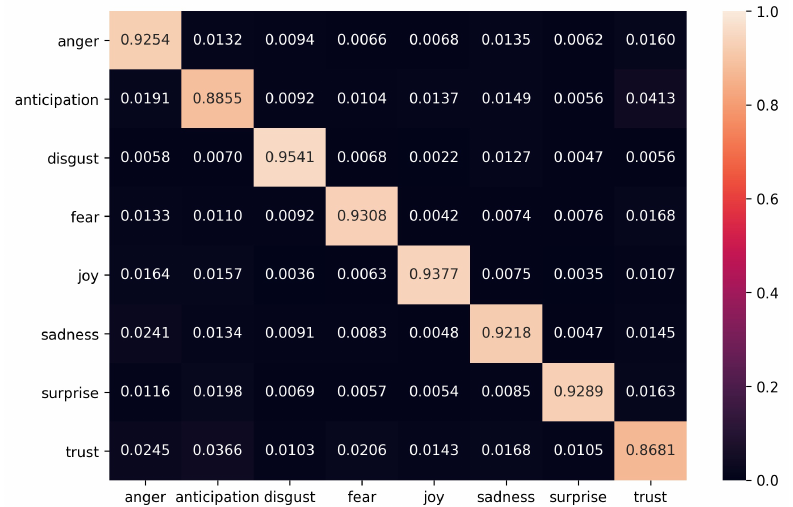
Figure 9. The Confusion matrix with the classification results of the LSTM